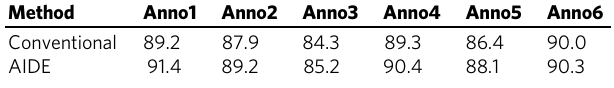
Table 3 Segmentation performance (DSC: %) of Task1_Prostate Segmentation on the QUBIQ datasets.